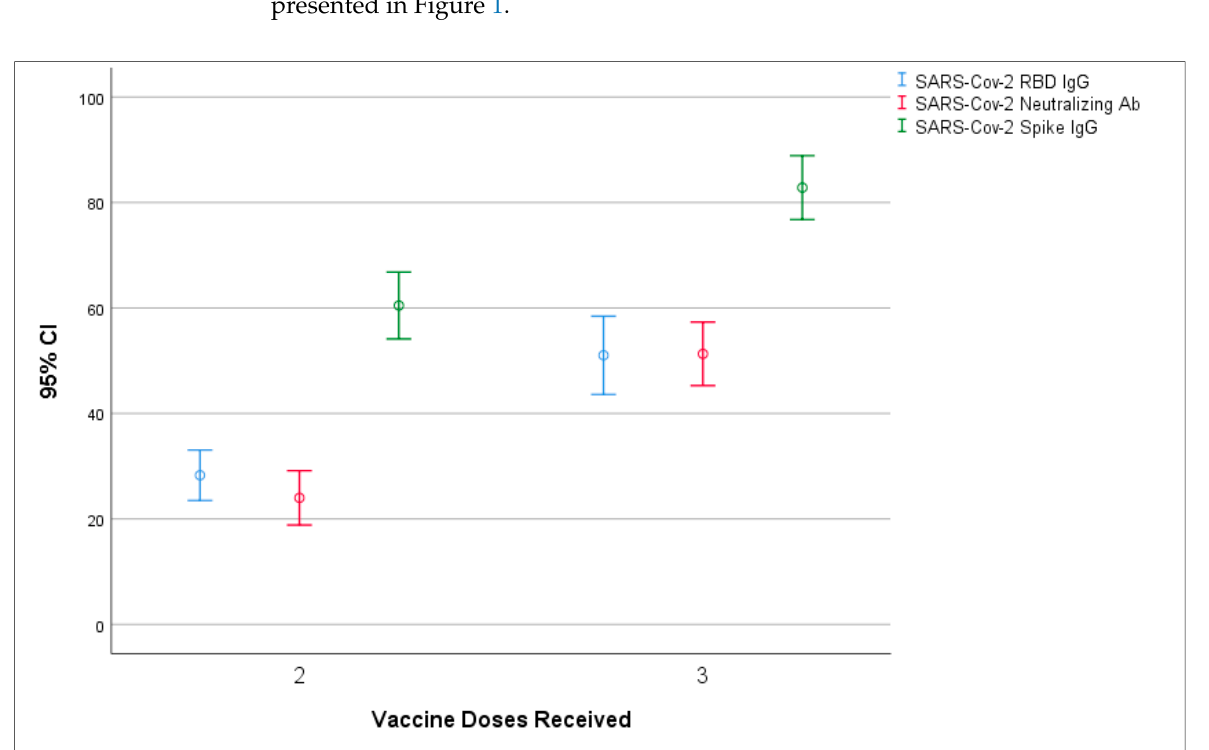
Figure 1. Comparison of the serum level of antibodies in twice- and triple-vaccinated individuals. To control the confounding variables in the prediction of positive levels of antibodies, age, gender, BMI, past medical history of autoimmune disease, past medical history of chicken pox, and past medical history of influenza vaccination, along with the number of COVID-19 vaccine dosages, have been entered into three separate logistic regression models. The result of the logistic regression for each antibody is presented in Table